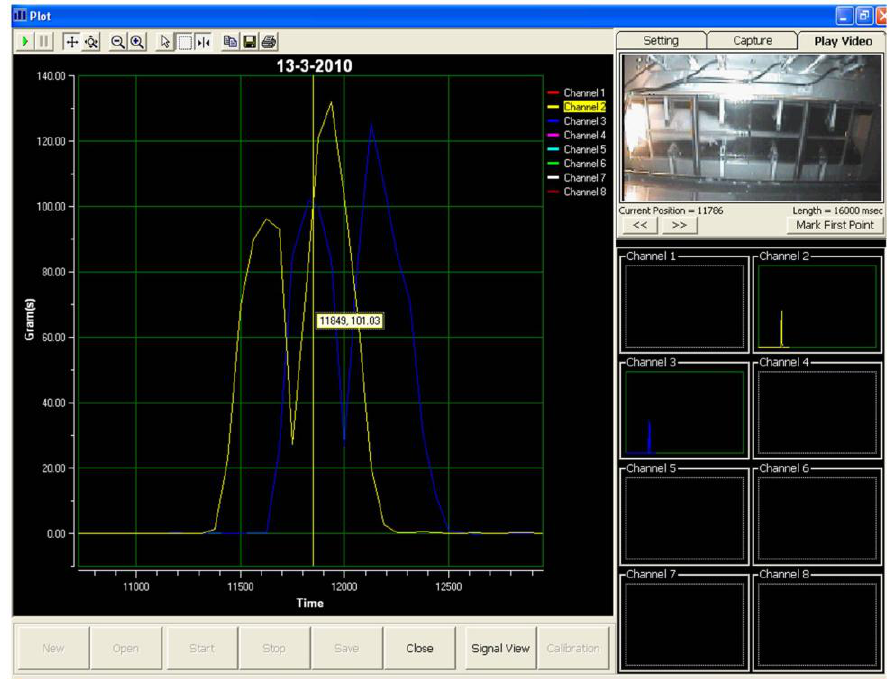
Figure 8. Smooth movements of the